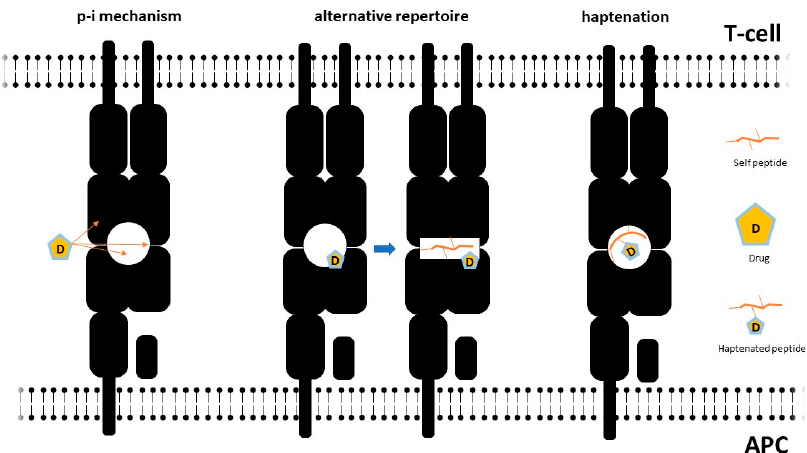
Figure 2. Pathogenic mechanisms for HLA-restricted, drug-induced activation of T-cells in DRESS. In this simplified depiction of HLA-restricted antigen presenting cell (APC)–T-cell interactions, the three main hypothesised mechanisms accounting for drug-induced T-cell activation in DRESS are represented. Drugs might directly interfere with HLA–T-cell receptor interactions, causing T-cell activation without the need for self peptides (p-i mechanism, left side). In this setting, drugs might activate the T-cell receptor through allosteric mechanisms or by binding HLA either inside or outside the peptide binding groove. Drugs bound to the peptide groove might cause conformational changes enabling self-peptides to be accommodated within HLA and presented to T-cells, promoting self-reactive responses (alternative peptide repertoire hypothesis, central section). Drugs can also bind self molecules through conventional hapten-carrier models ( right side).